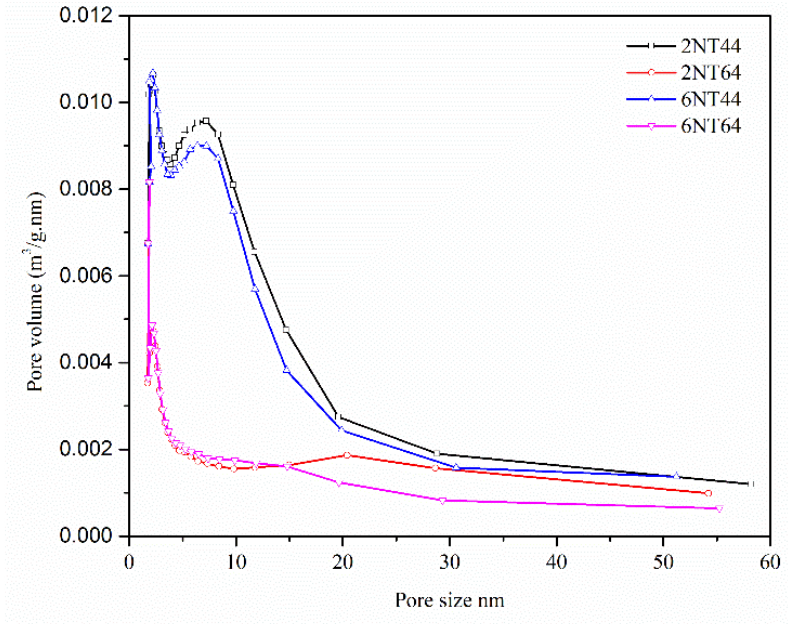
Fig. 5. Pore size distribution for different N-doped TiO2